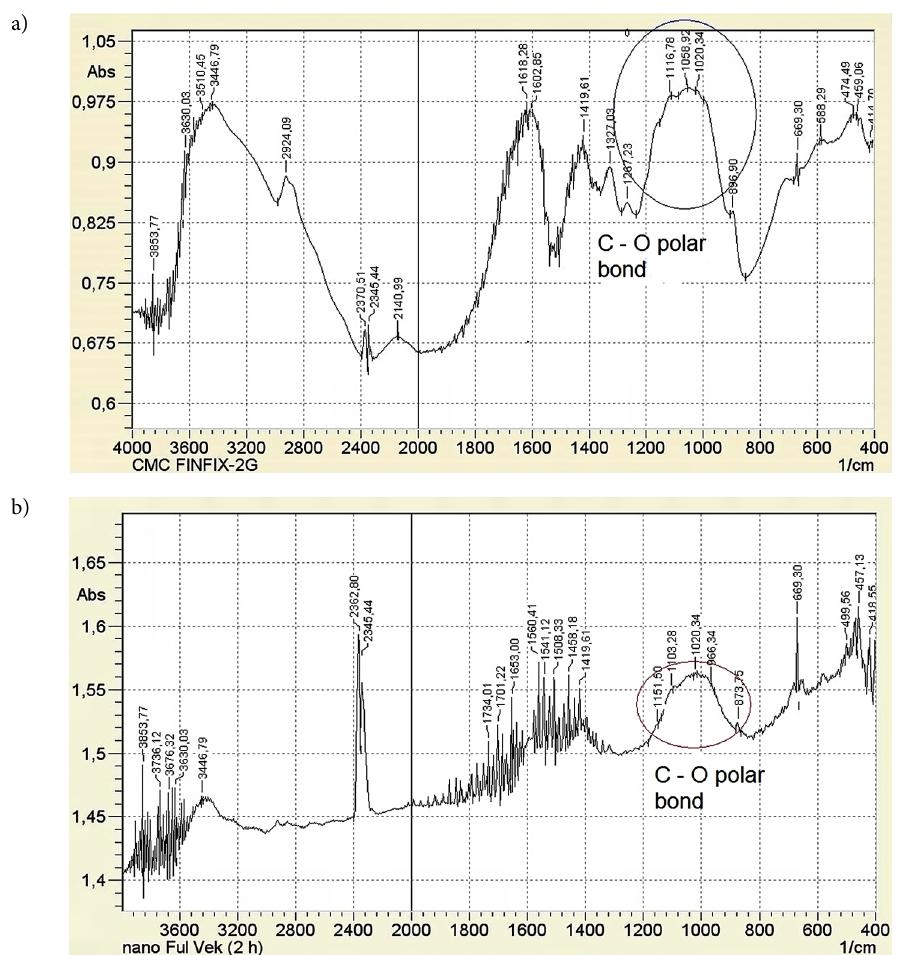
Fig. 1. IR spectrum of adsorption: a – of carboxymethylcellulose; b – of suspension processed for